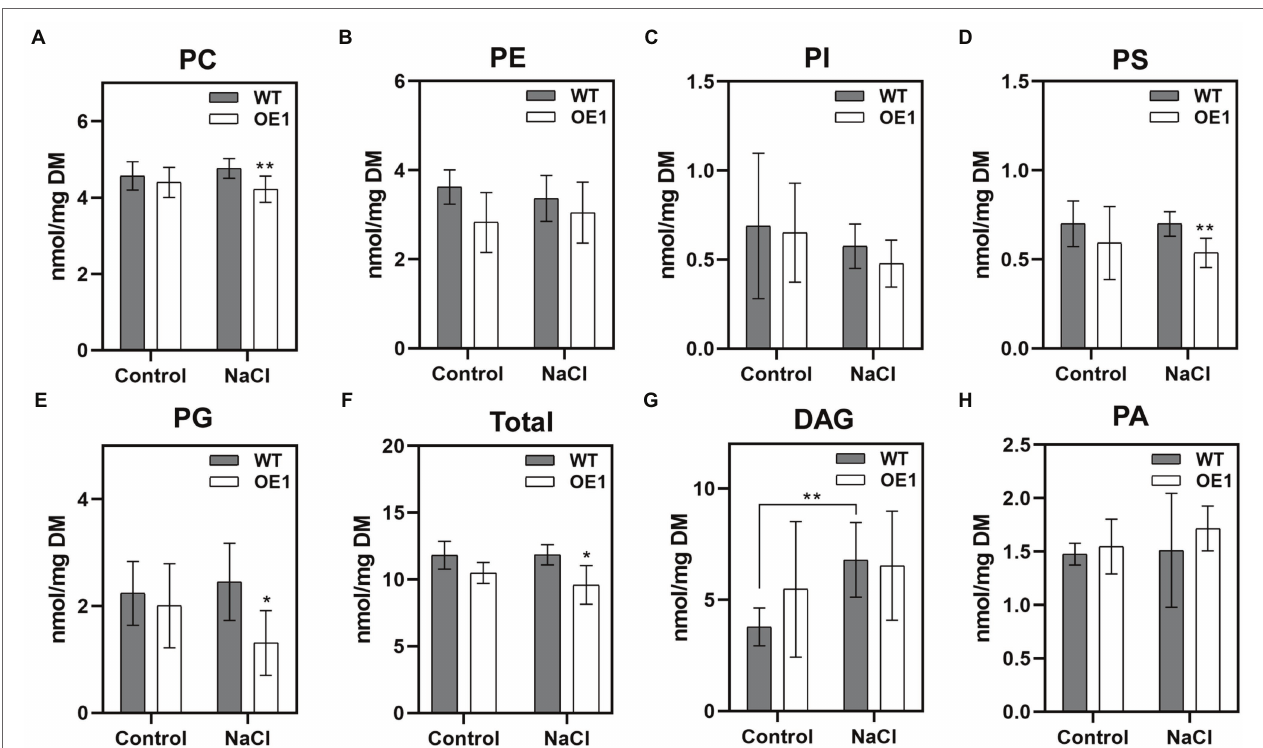
FIGURE 7 | Effect of GlNPC3 overexpression on membrane lipid contents in A. thaliana . (A–H) Comparison of lipid changes between the WT and OE1. Total lipids were extracted from 10-day-old medium-grown A. thaliana seedlings that were exposed or not to 150 mM NaCl for 45 min. Lipids were quantified by electrospray ionization tandem mass spectrometry (ESI-MS/MS). Total lipids refer to the amounts of PC, PE, PI, PS, and PG. Data represent means ± SD of five replicates (each replicate contained 15 ~ 20 plants). Asterisks indicate significant differences from the WT: * p ≤ 0.05; ** p ≤ 0.01, Duncan’s multiple range test. DM, dry